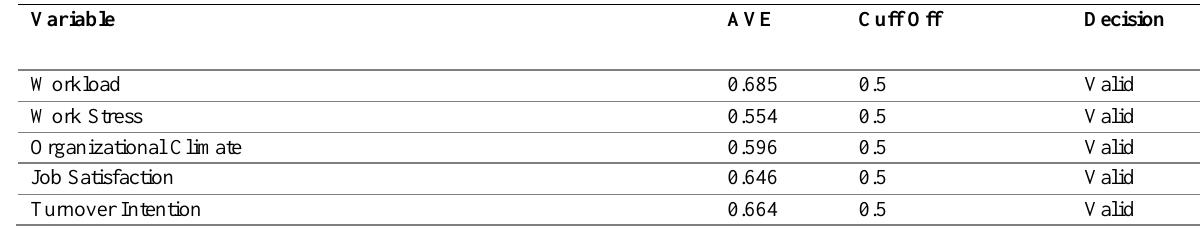
Table 3: Results of Average Variance Extracted (AVE)